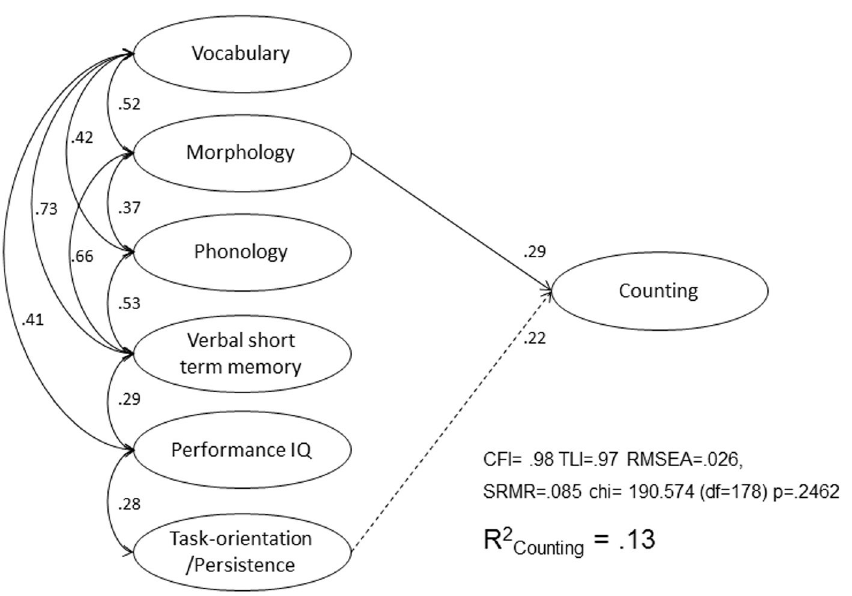
Figure 2. The model with all significant paths of the language-related predictors and persistence